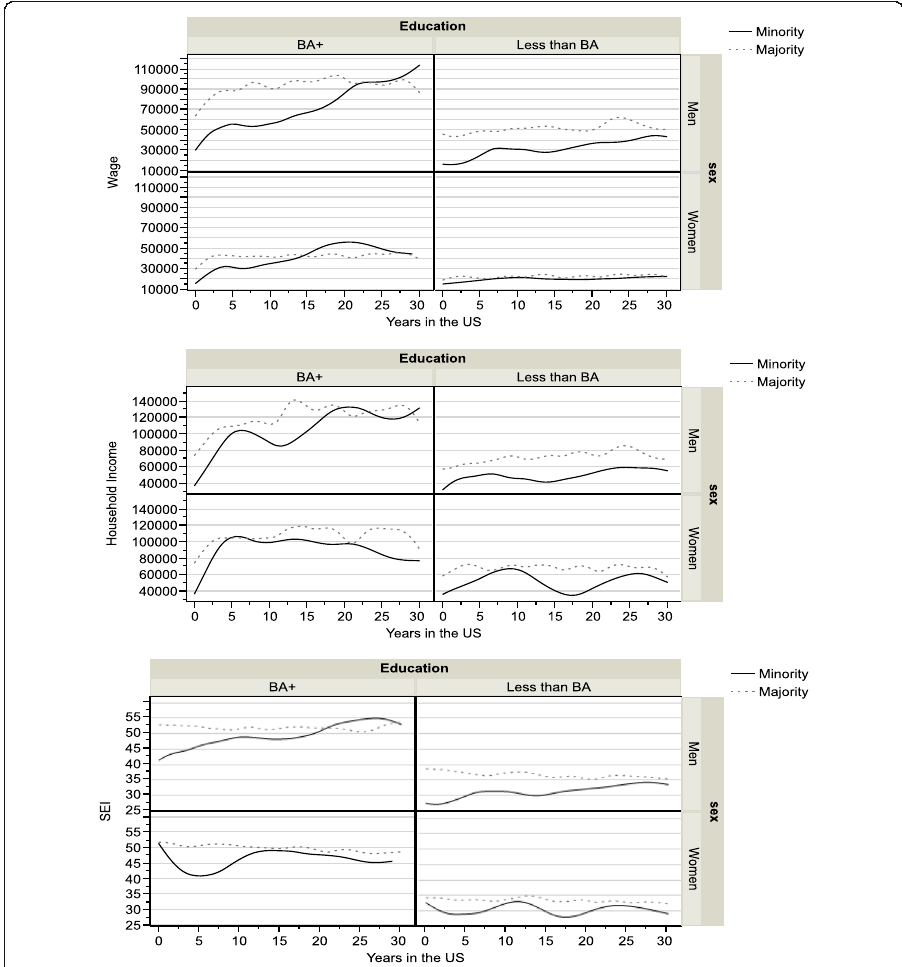
Fig. 1 Graphs of economic advancement over the years: non-black immigrant minorities vs. immigrant majorities, age 25 to